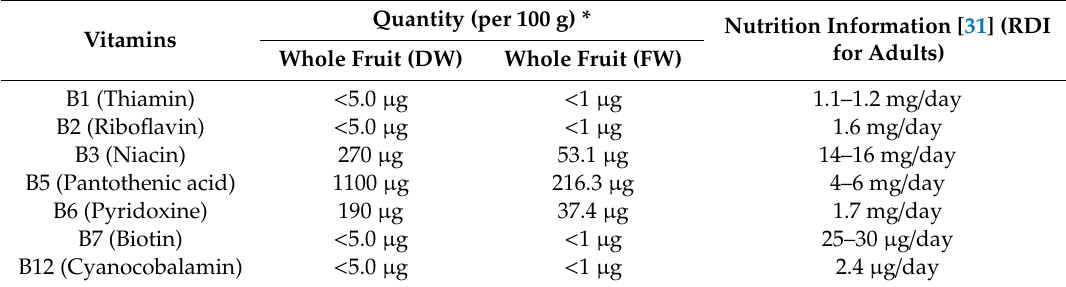
Table 5. Selected B-vitamins in feijoa whole fruit powder.